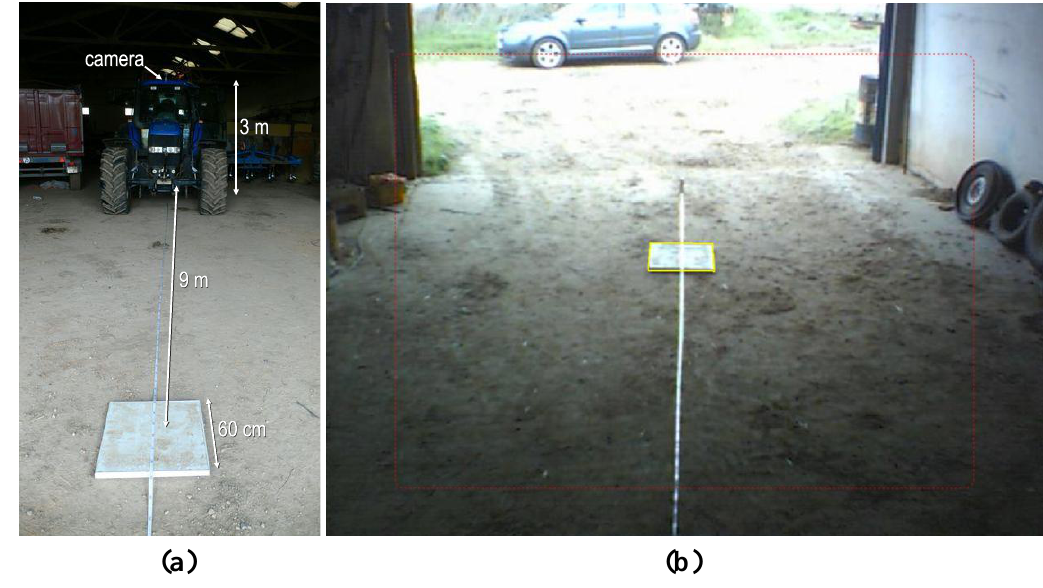
Figure 4. ( a ) Photo of the tractor and the object placed to calibrate the tractor video camera. ( b ) The representation, in yellow, of the 3D modeled square over the real image during the process of getting the camera